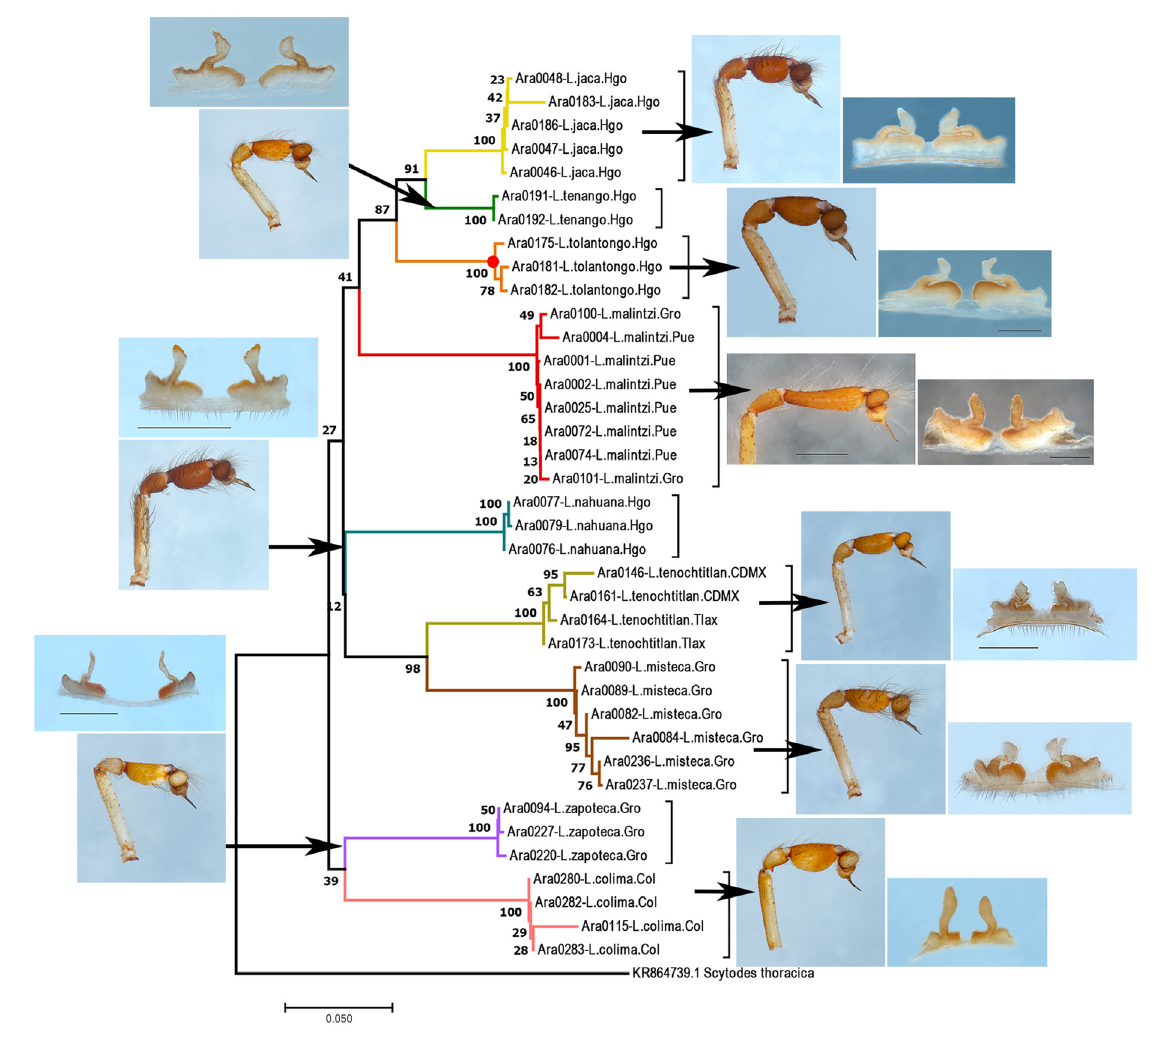
Fig. 52. Neighbor joining tree constructed from CO1 data of nine species of Loxosceles Heineken & Lowe, 1832 from Mexico. Colors of branches indicate different species. Numbers on nodes are bootstrap support values. Red circle at node represents Loxosceles tolantongo sp.